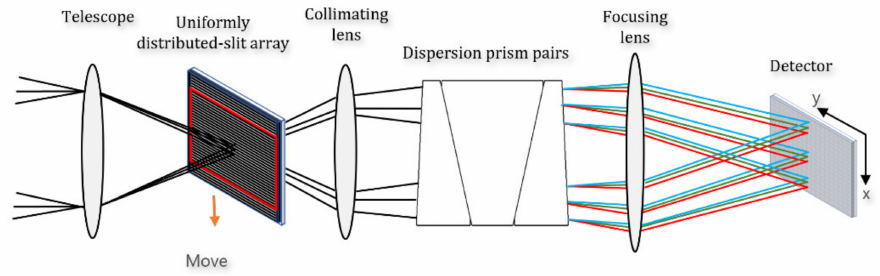
Figure 1. Uniformly distributed-slit array coded spectral imaging